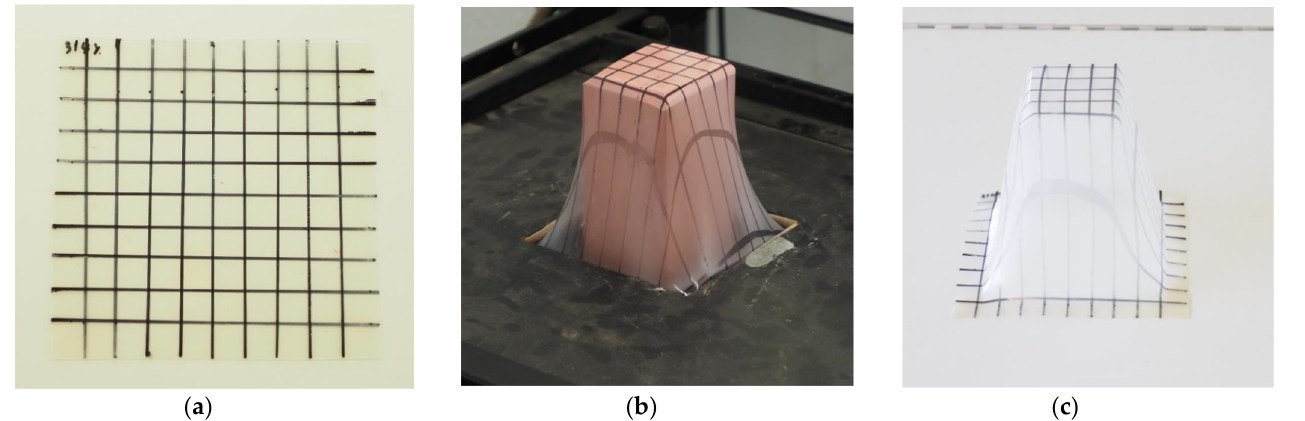
Figure 9. Different stages thermoforming, ( a ): film with grid pattern; ( b ): the film being thermoformed; ( c ): the thermoformed film.